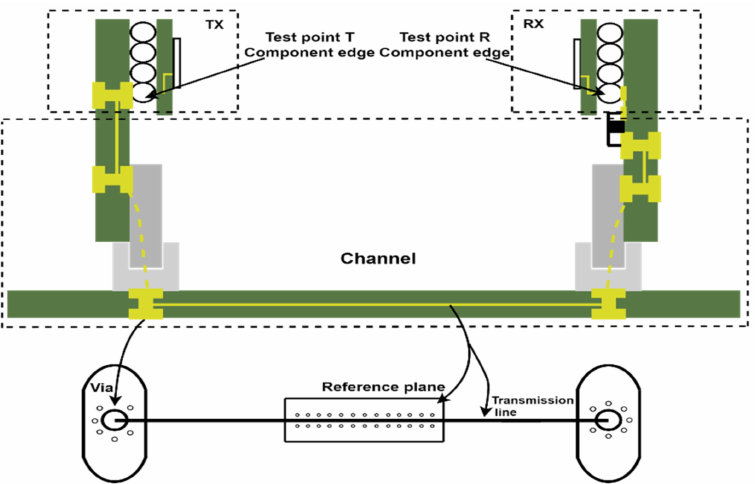
Figure 1. Schematic diagram of high-speed passive